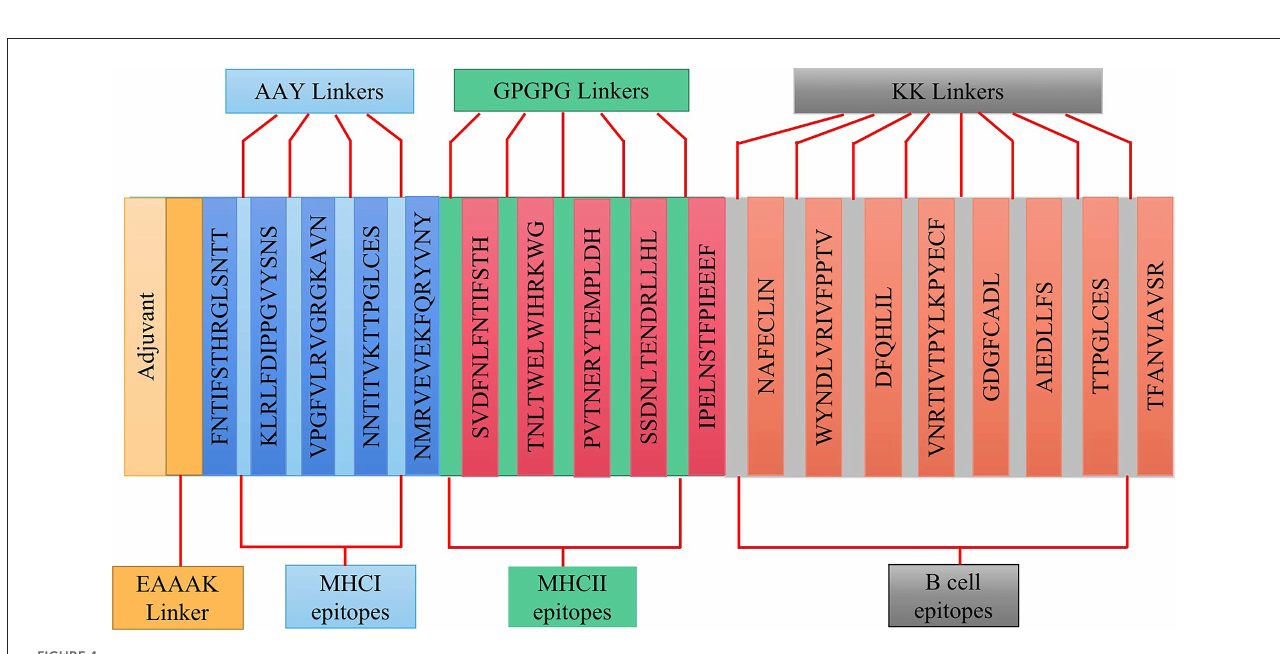
FIGURE4 SADS-CoV multi-epitope vaccine